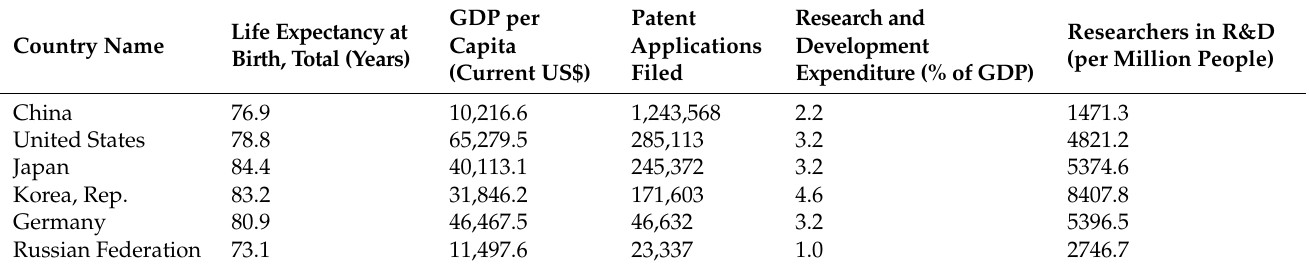
Table 3. Comparison of the world’s leading economic countries by patent level, research and development costs, number of researchers, and life